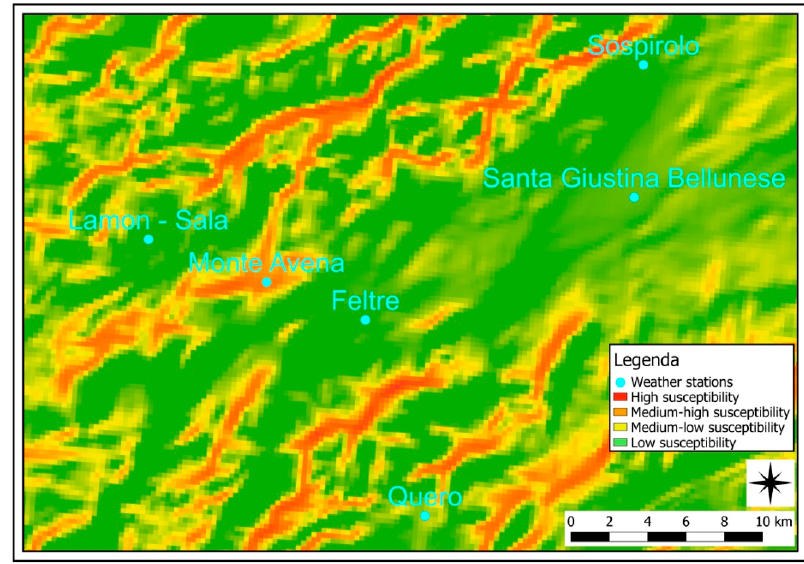
Figure 19. Wind damage susceptibility map.